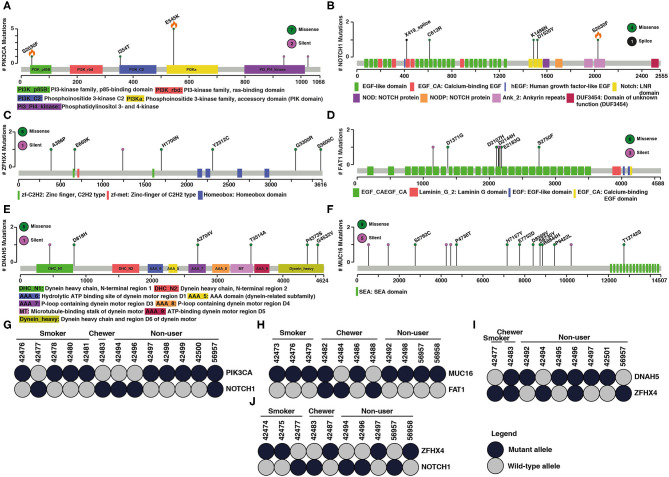
Examples of mutated genes that showed mutual exclusivity. Schematic representation of coding variant distribution on proteins (A)
PIK3CA, (B)
NOTCH1, (C)
ZFHX4, (D)
FAT1, (E)
DNAH5, and (F)
MUC16. Green indicates missense mutation, black indicates splice site and purple indicates silent mutation. Total number of different type of mutations for each gene is given within the circle on right side. X-axis represents length of the protein (amino acid) and y-axis represents number of samples. Orange flame indicates COSMIC hotspot mutations. Instances of gene pairs with mutually exclusive mutation pattern in ESCC (G–J)
PIK3CA and NOTCH1, MUC16 and FAT1, DNAH5 and ZFHX4, ZFHX4 and NOTCH1. Column represents samples and row represents genes. Dark shaded circles indicate the mutant allele and the gray circle indicates wild type allele.